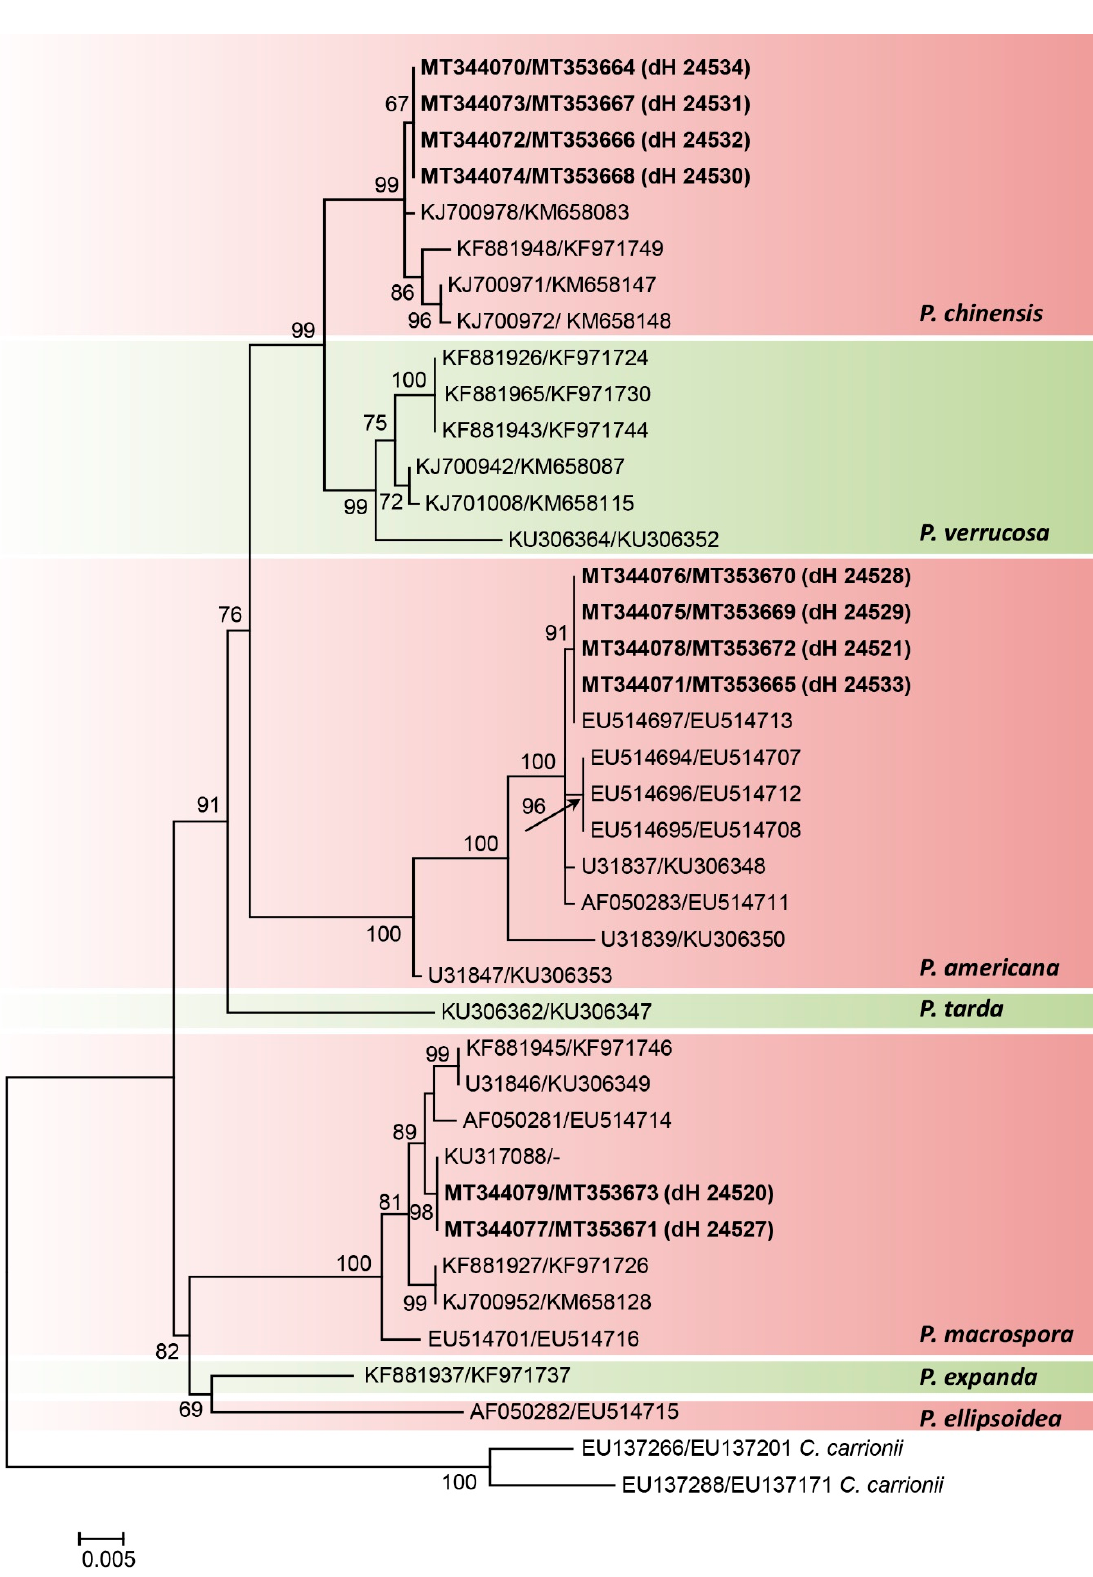
Figure 3. Combined Internal Transcribed Spacer (ITS) and β -tubulin ( TUB2 ) phylogeny of the genus Phialophora obtained by maximum likelihood method (bootstrap values are indicated at the nodes). Sequences of the clinical isolates recovered from the cases presented in this study are indicated in bold. Cladophialophora carrionii is used as an outgroup. Taxa labels are the GenBank accession numbers of ITS/ TUB2 .